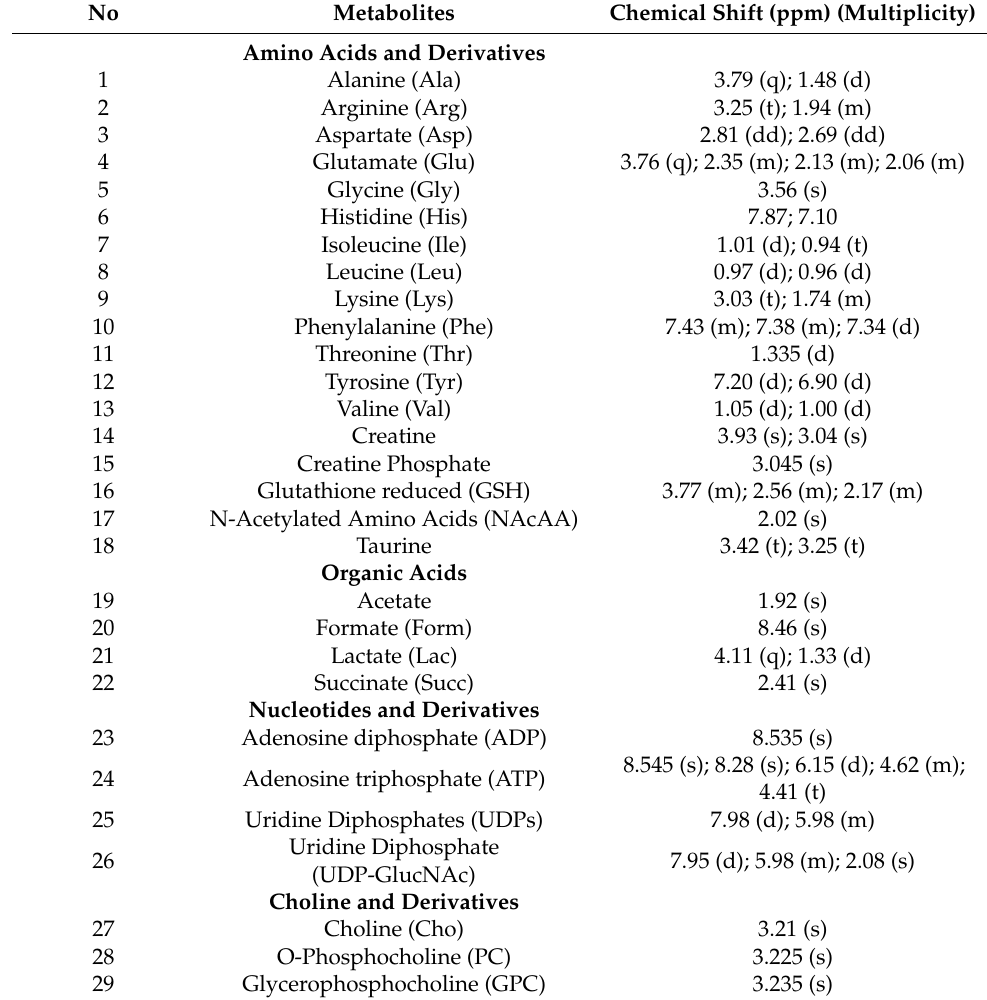
Table 2. 1 H chemical shifts (ppm) of metabolites identified in the 1 H NMR spectra of aqueous extracts of untreated MG-63 cells and those treated with ADR (50 nM), OLEU (20 µ g/mL) and ADR+OLEU (50 nM + 20 µ g/mL) for 48